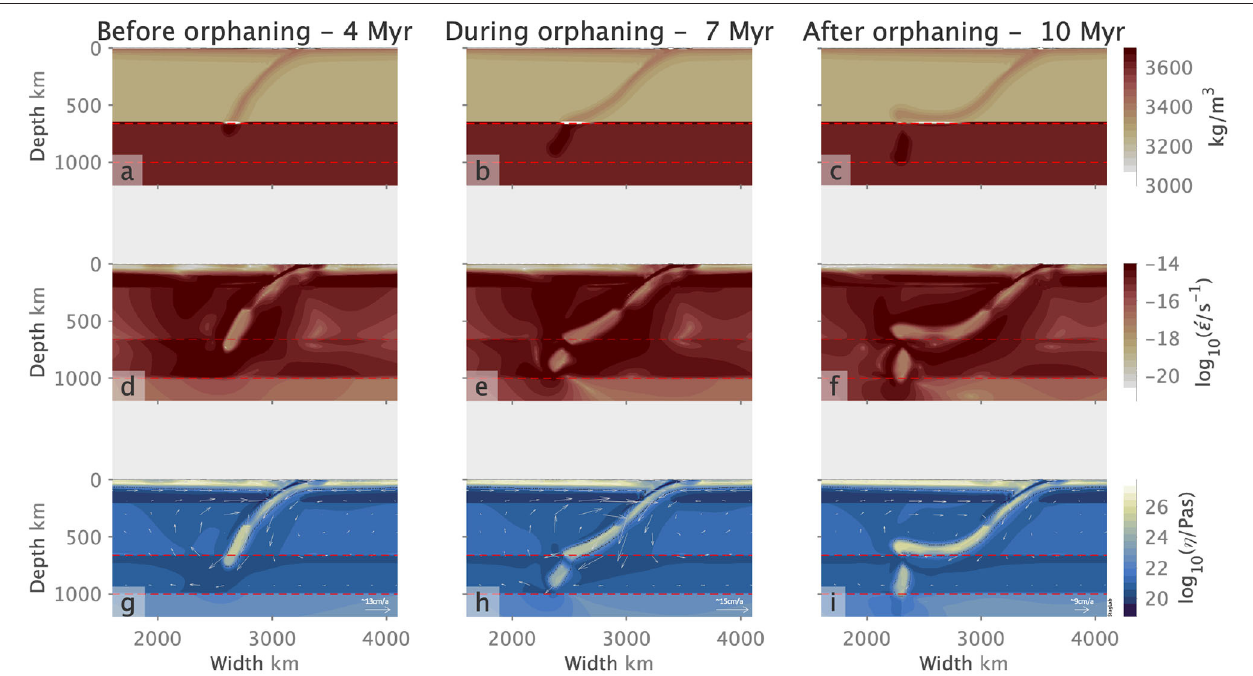
FIGURE 2 | Each panel represents a time slice in the evolution of our standard model V 3(600) i . (a–c) (Density) The temperature dependence of the phase boundary depth introduces a low density lens within the cold slab core at 660 km depth and resists the slab’s penetration into the lower mantle. Continued subduction increases the lateral extent of the lens and encourages the flattening of the proto-parent (d–f) (Strain Rate) Higher slab sinking velocities in the LVL increase the strain rates within the proto-orphan. As the slab and proto-orphan have reached their maximum stress, the higher strain-rates are accommodated by a decrease in viscosity of the proto-orphan, weakening it. (g–i) (Viscosity) The change in flow direction from predominantly vertical in the upper mantle to horizontal in the LVL encourages the shearing of the proto-orphan from its